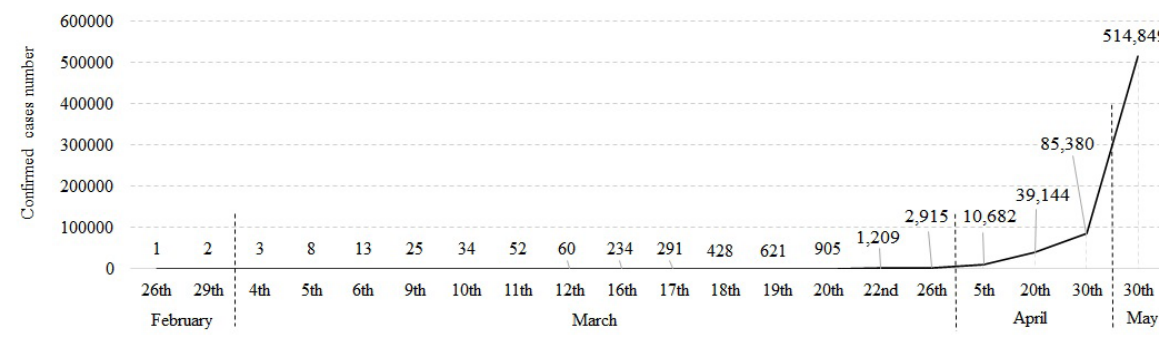
Figure 4. Infographic showing the evolution of the cases in Brazil. All numbers are associated with confirmed cases through the PCR test. The last data was recovered from the Brazilian Ministry of Health in May 30 th which also computed 29,314 deaths by